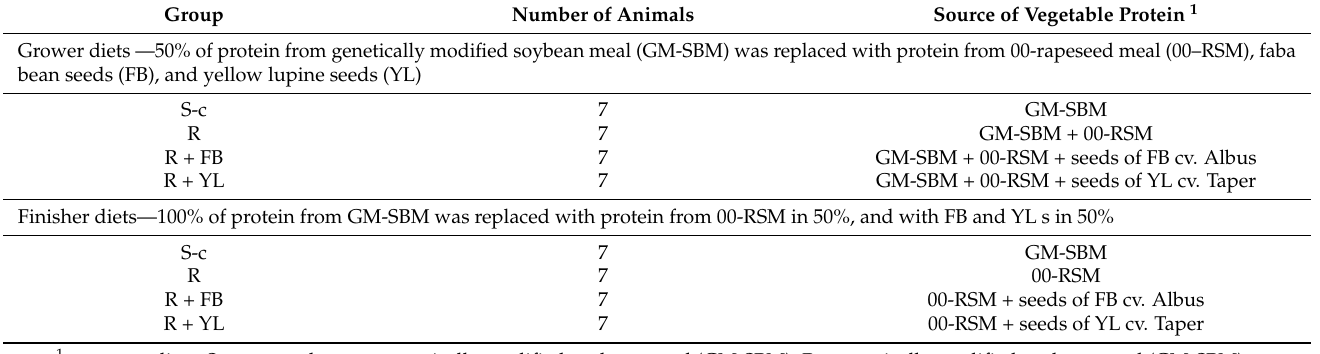
Table 2. Feeding trial